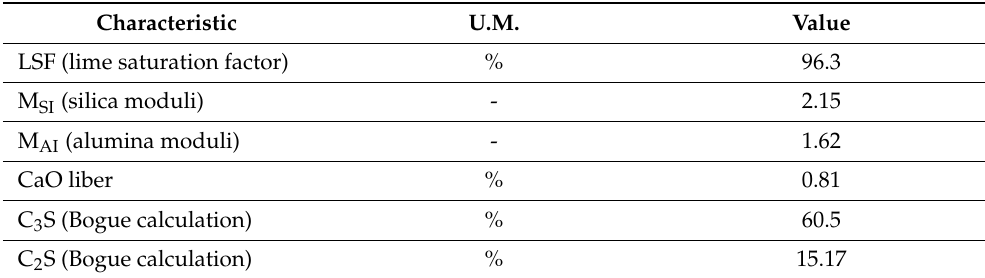
Table 2. Chemical analysis of clinker after preparation (according to [19] and [20]). Characteristic U.M.